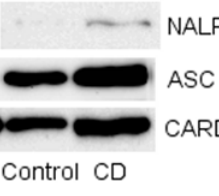
Figure 5. Expression of inflammasome related proteins. Immunoblotting of NALP3, ASC, and CARD8. Monocytes expressed all these proteins involved in caspase 1 maturation.